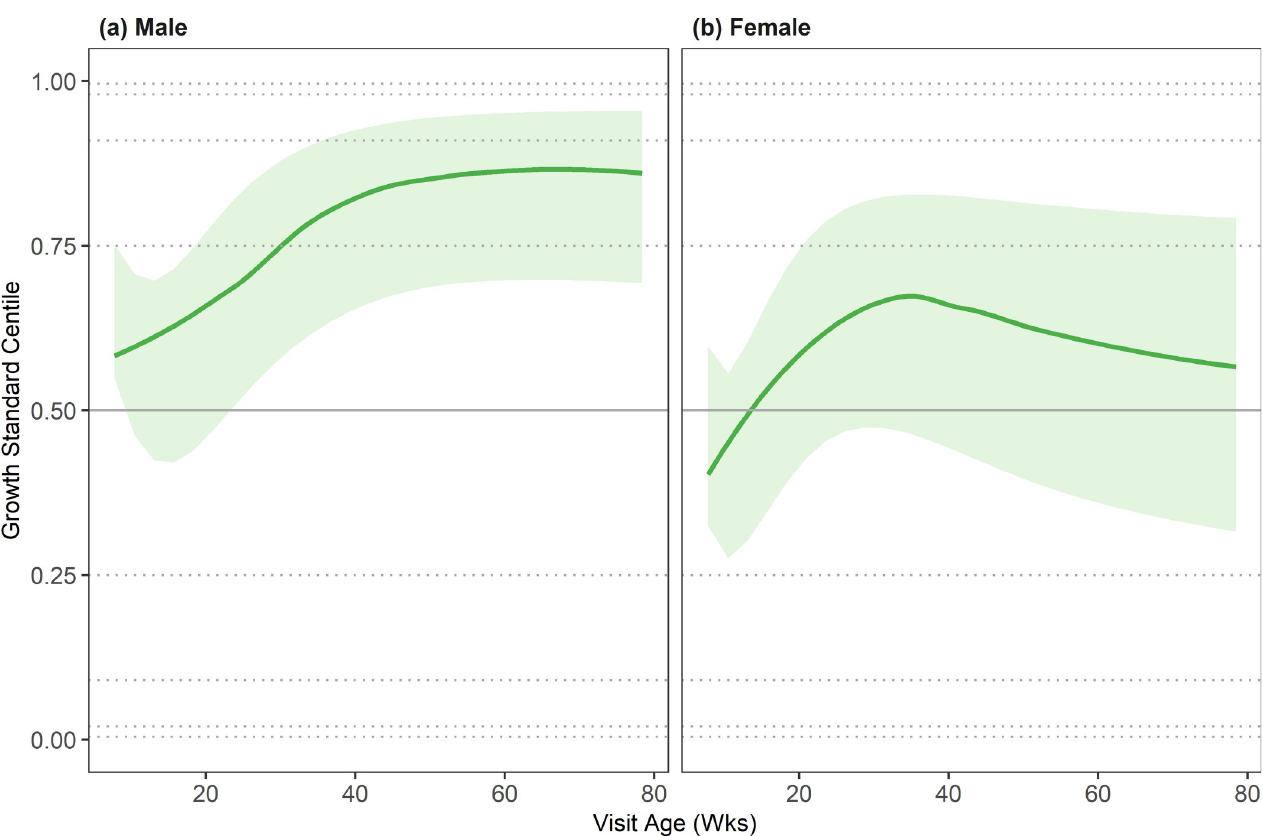
Fig 2. Median and interquartile weight by age (on the centile scale) for DSH kittens in the research colony data set. Plots are split by sex: (a) male and (b) female. On each graph, the median is depicted by the solid green line, the interquartile range by the shaded region, and the standard centiles (0.4%, 2%, 9%, 25%, 50%, 75%, 91%, 98% and 99.6%), as calculated from the growth standard population, are shown by the grey horizontal lines (dotted, apart from 50%, which is shown as